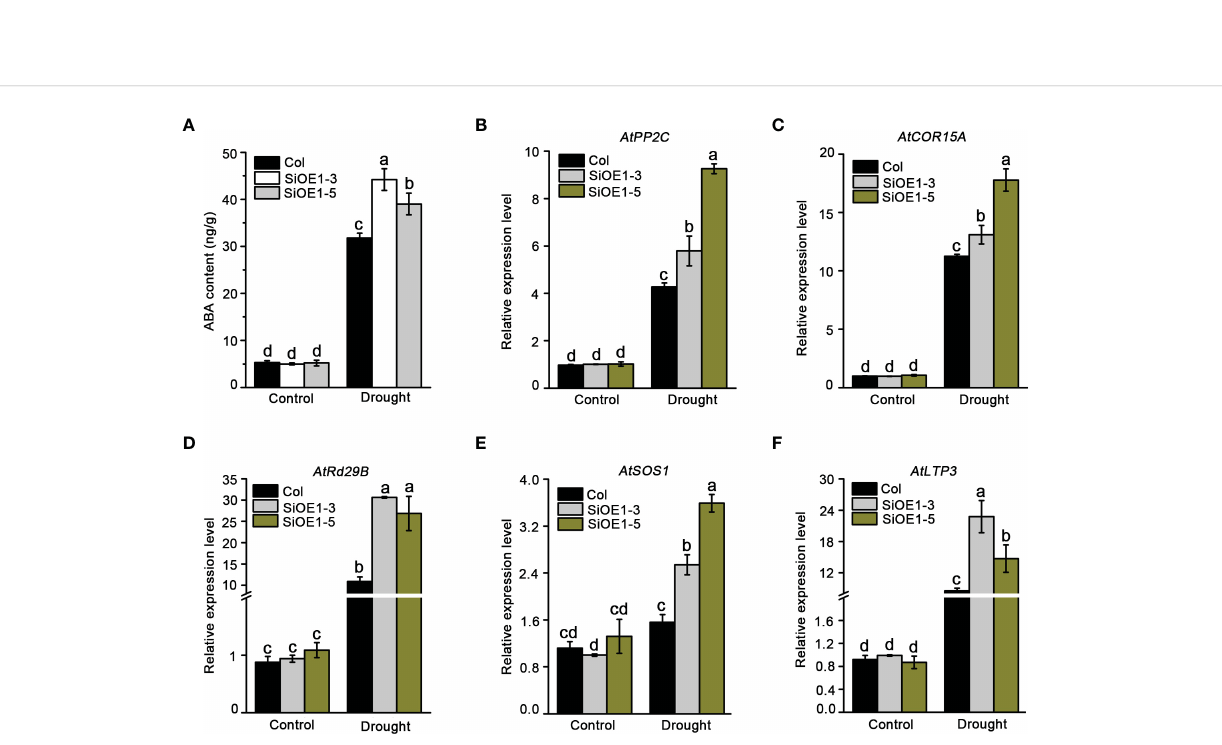
FIGURE 6 ABA content and abiotic stress related genes expression. (A) The ABA content in seedlings of Col and SiNCED1 -overexpressing plants under drought stress. (B – F) The expression of ABA related stress responsive genes in Col and SiNCED1 -overexpressing plants under drought stress for 7 d. Data shown are mean ± SD from there independent replicate. Different letters represent signi fi cant differences at P <0.05 (ANOVA analysis, Tukey ’ s multiple comparisons test )